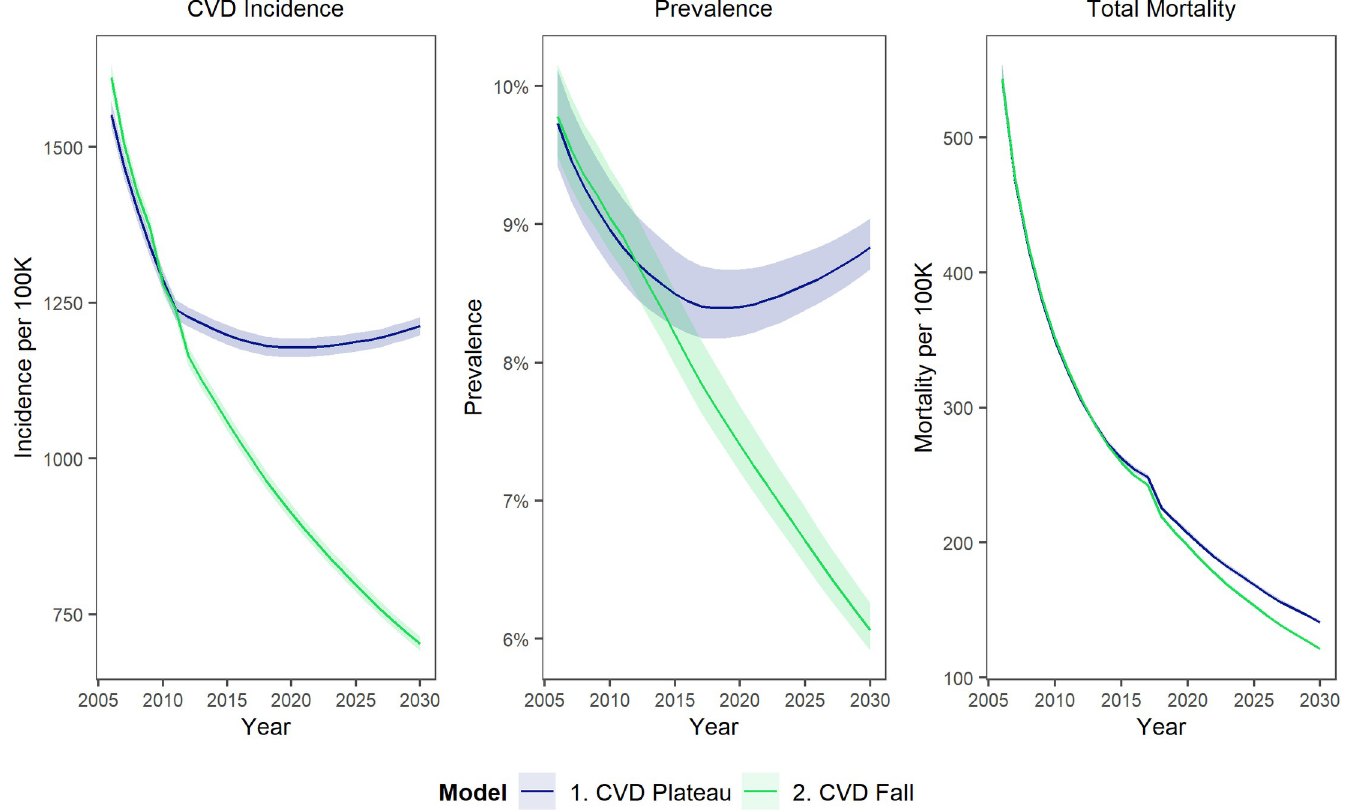
Fig 1. Modelled CVD incidence per 100,000 population aged 35–100, prevalence (% of people aged 35–100), and mortality per 100,000 population aged 35–100, from 2005 to 2030, comparing Scenario 2 (Continuing decline in CVD incidence) with Scenario 1 (plateaued CVD incidence).